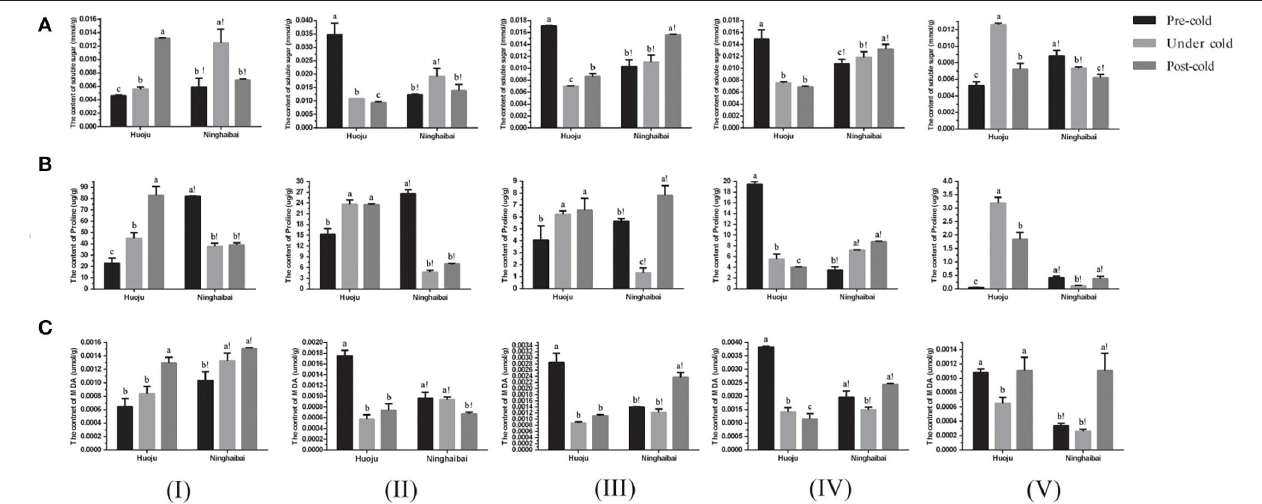
FIGURE 2 | Changes in content of soluble sugar (A) , proline (B) , and MDA (C) in different organs of two loquat varieties. I–V in the graph indicates sampling organs, including showing-white flower, blooming flower, unclosed calyx, closed calyx, and rachis. Different letters indicate the significance at p < 0.05, out of which a, b, and c indicate the significant difference of “Huoju,” whereas a!, b!, and c! indicate the significant difference of “Ninghaibai.” Error bars indicate the standard deviation based on three replicates.